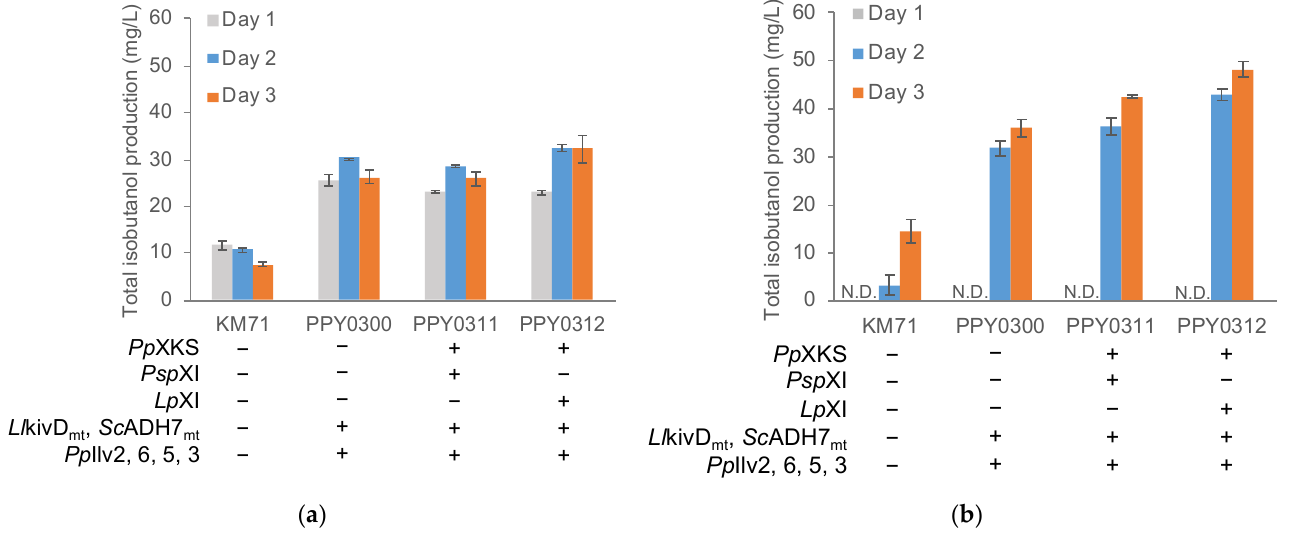
Figure 5. Total isobutanol production of engineered P . pastoris in a sugarcane trash medium . ( a ) Isobutanol production in minimal medium with sugarcane trash hydrolysates with a total sugar content of 1.5%; ( b ) isobutanol production in minimal medium with sugarcane trash hydrolysates with a total sugar content of 2%. N.D.—not detected.